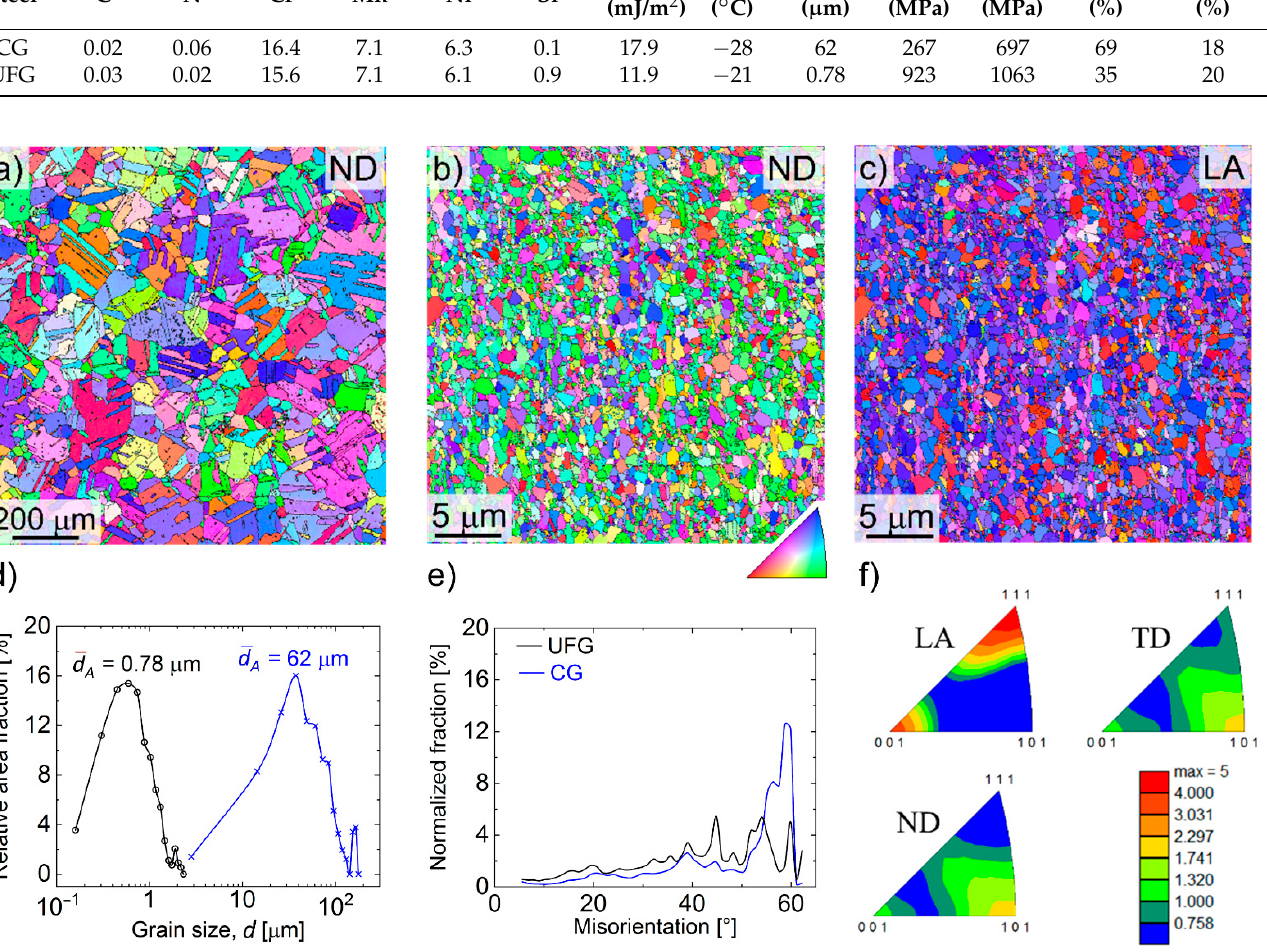
Figure 1. Initial microstructures of CG and UFG materials conditions obtained from EBSD investi- gations. ( a – c ) Crystallographic orientation maps of CG ( a ) and UFG ( b , c ) conditions. ( d ) Grain size distributions. ( e ) Misorientation distributions. ( f ) Texture of UFG material. ND—normal direction, TD transverse direction, LA—loading axis.